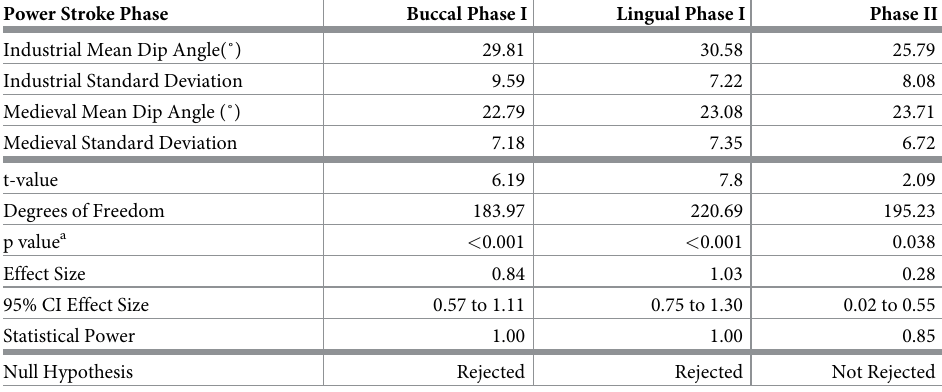
Table 7. Result of independent sample t-tests comparing mean dip angles of the wear facets of the lower second molar between the industrial and pre-industrial groups.